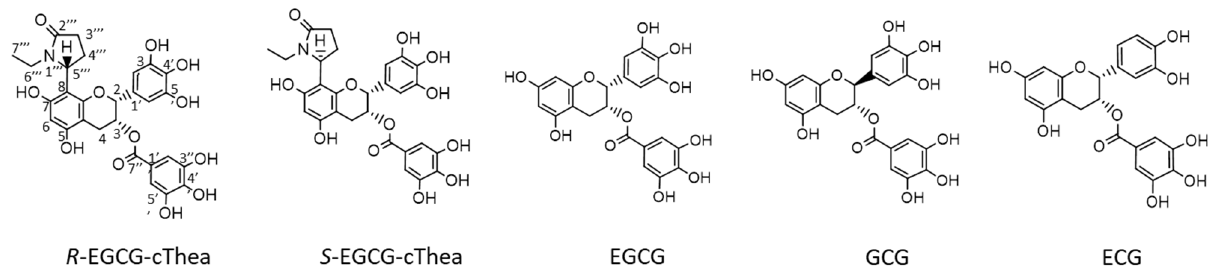
Figure 1. Chemical structures of R -EGCG-cThea, S -EGCG-cThea, epigallocatechin-gallate (EGCG), gallocatechin-gallate (GCG), and epicatechin-gallate (ECG).